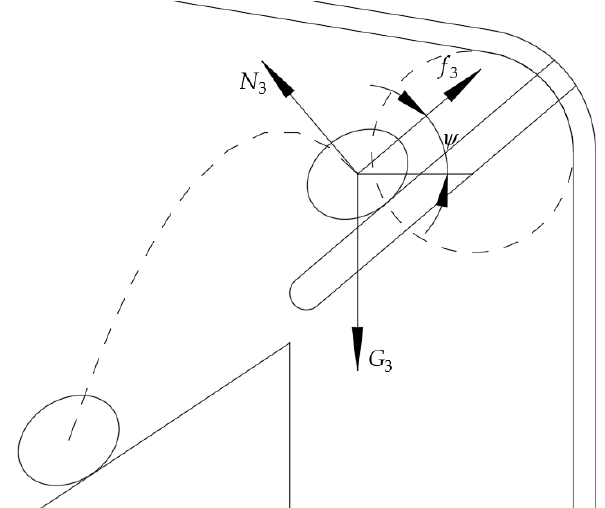
Figure 13. Potato force diagram in the unloading section of the circulating and lifting device.